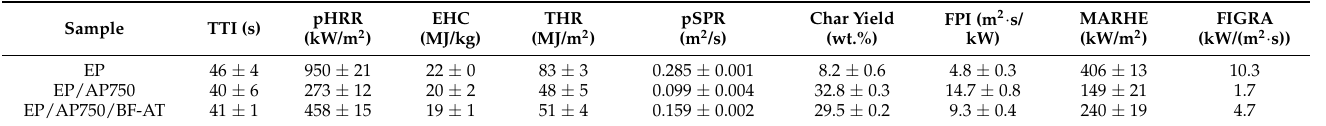
Table 4. Cone calorimeter test (CCT) data of EP and EP